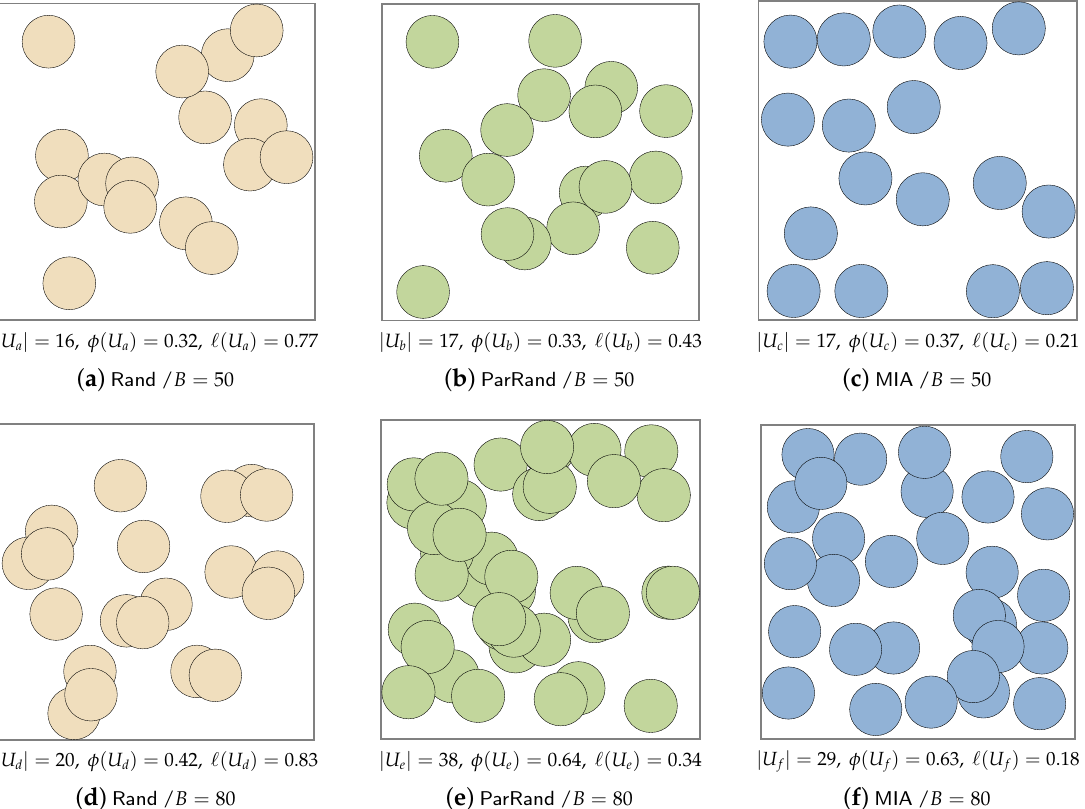
Figure 7. Snapshots of the final sensing coverage after the three algorithms terminate in two common experiments. Both experiments have 200 available users, but one experiment is set with B = 50 and the other, with B =